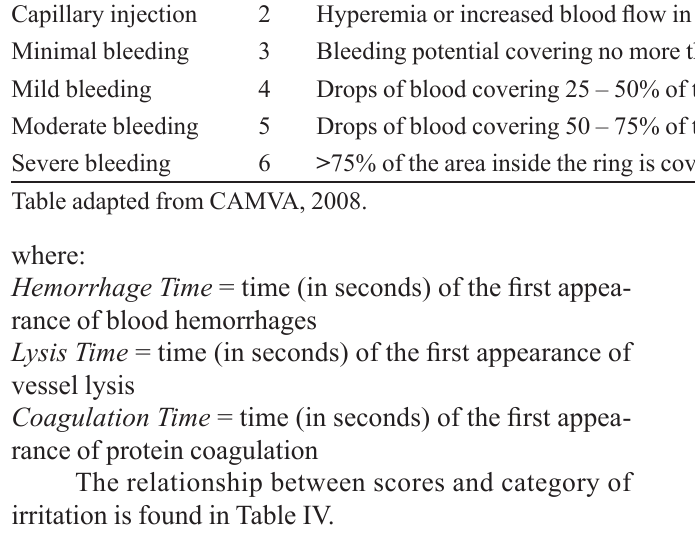
TABLE IV - Relationship of scores with category of irritation Scores on HET-CAM Table adapted from CAMVA,